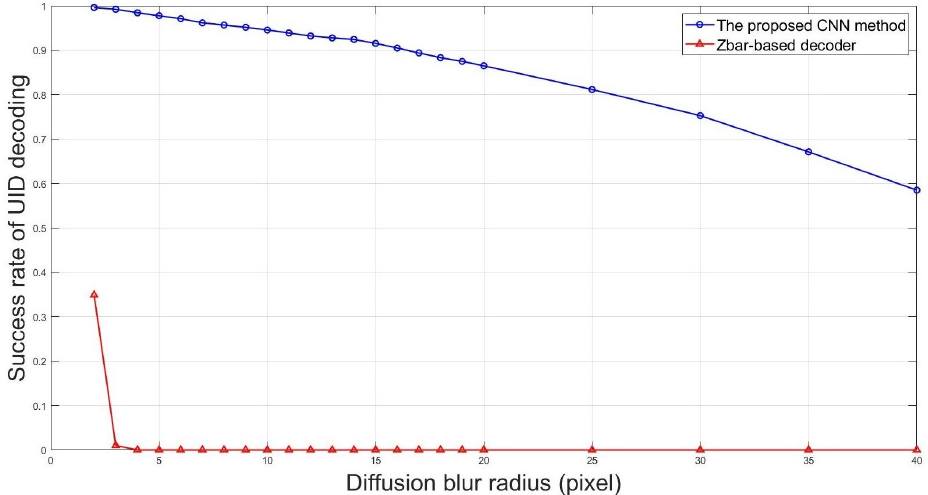
Figure 14. Success rate of UID decoding for diffusion blurred images using the proposed BN-CNN model versus that using the Zbar-based